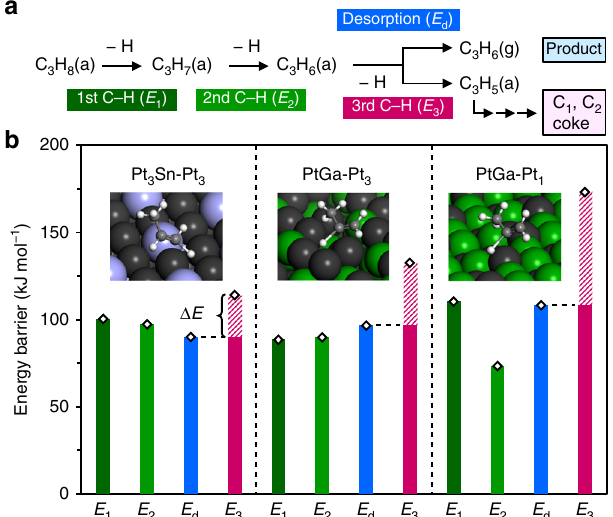
Fig. 5 Theoretical interpretation of propylene selectivity. a The reaction scheme of PDH to generate propylene and undesired products. b The energy barriers of each C – H scission and propylene desorption on Pt 3 Sn (111)-Pt 3 , PtGa:A(111)-Pt 3 , and PtGa:A(111)-Pt 3 . Inset picture shows the transition state structure in the third C – H scission for each surface. Dark green, light green, magenta, and cyan bars represent the activation energies for fi rst ( E 1 ), second ( E 2 ), third ( E 3 ) C – H scissions, and propylene desorption ( E d ), respectively. Shaded parts in magenta bars correspond to Δ E ( Δ E = E − E 3 d